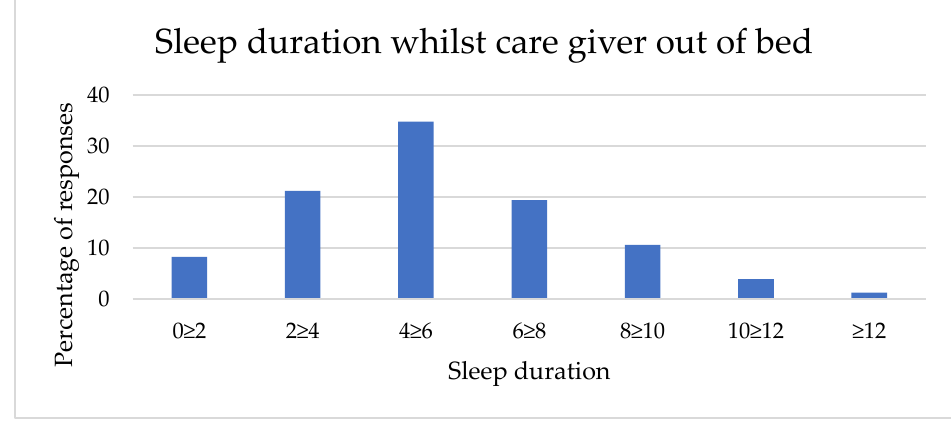
Figure 2. Caregiver-reported sleep duration of their dog whilst the caregiver was out of bed.